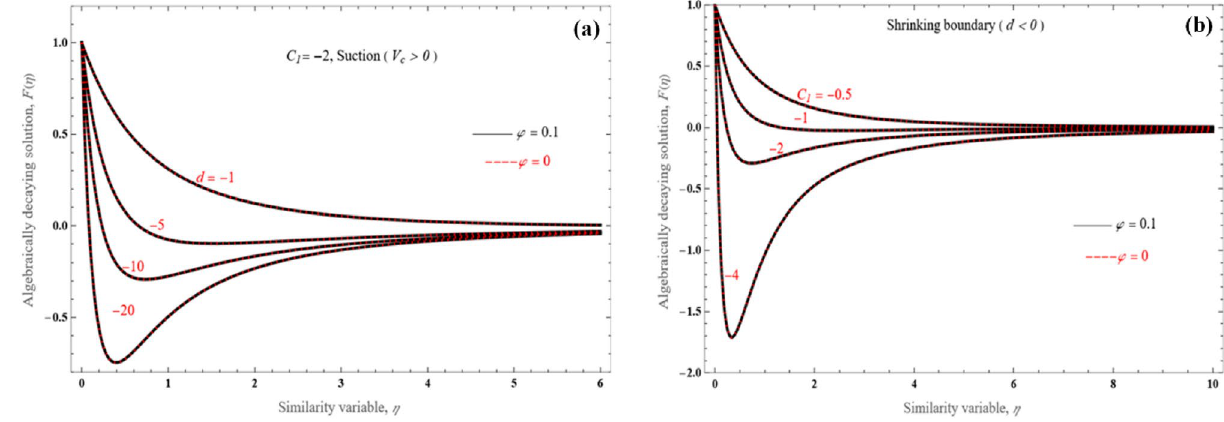
Figure 7. F (η) vs. the similarity variable for ( a ) various values of d and ( b ) various negative values of C 1 .